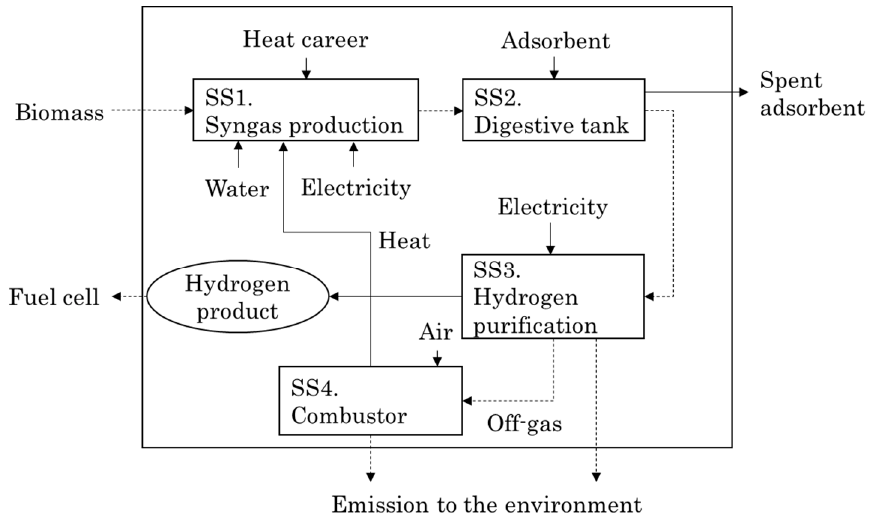
Figure 3. System boundary of hydrogen production.